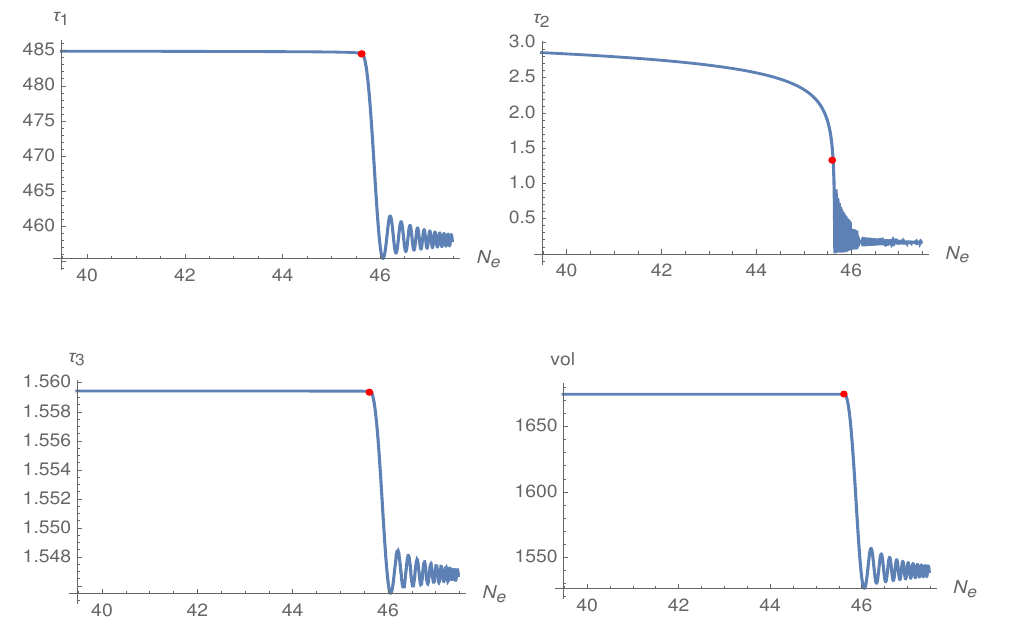
Figure 7 . In(cid:13)ationary evolution of all (cid:12)elds during the last 8 efoldings for the third case in table 2 and 3. The red dot denotes the end of slow-roll in(cid:13)ation where (cid:15) s = 1.